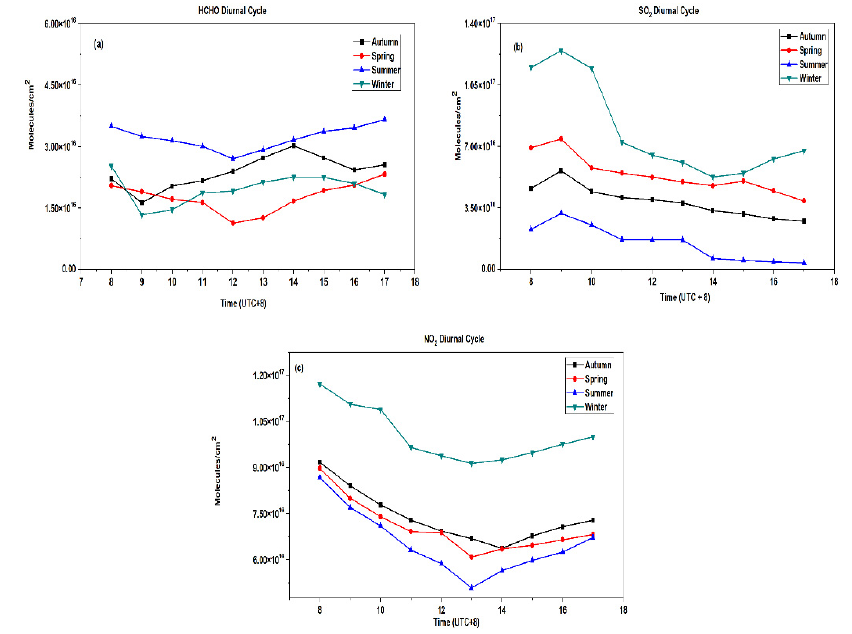
Figure 4. Diurnal cycle of ( a ) HCHO, ( b ) SO 2 , and ( c ) NO 2 for different seasons as obtained from MAX-DOAS observations.